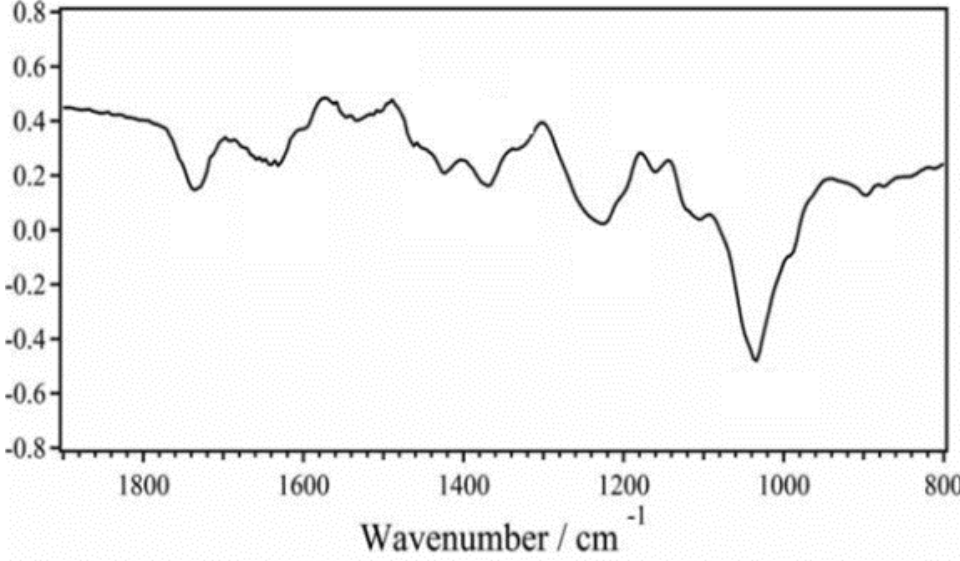
Figure 11. FTIR graph of polyaniline coated KF [28]. Reprinted from Water Science and Technology volume 78, issue number 5, pages 1137 – 1147, with permission from the copyright holders, IWA Publishing.